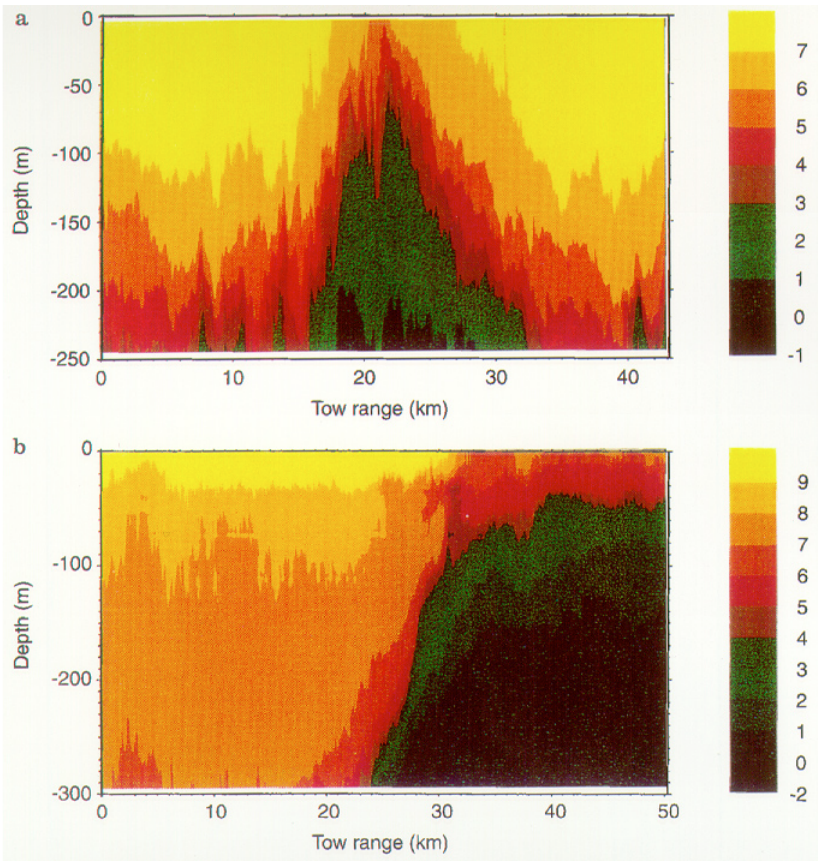
Fig. 3a, b. Thermistor chain tempera- ture sections through two oceano- graphic features: a a cold eddy in winter; b the western end of the Iceland-Faeroes front in summer. The temperature scale in ° C is shown on the colour -